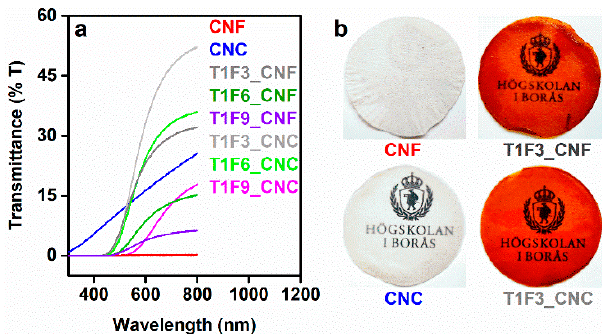
Figure 10. ( a ) Light transmittance spectra obtained from CNF, CNC, and their biocomposites. ( b ) Transparency images of CNF, CNC, T1F3_CNF, and T1F3_CNC films.